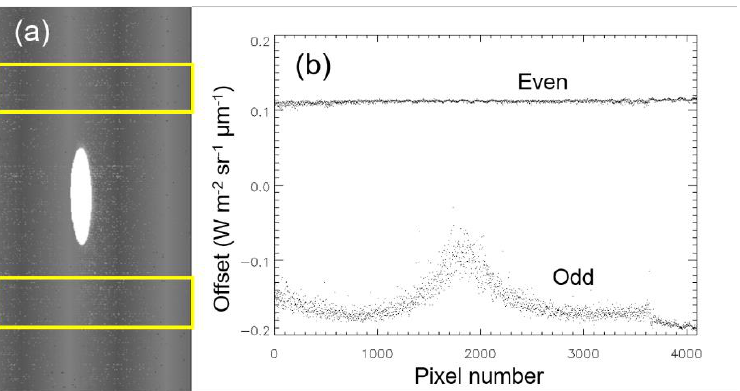
Figure 3. ( a ) An example of offset patterns observed in the VNIR images (Band 1, 2003). The brightness level was stretched to enhance the offset. ( b ) Measured offsets for each pixel obtained from averaging the apparent brightness in deepspace regions (indicated by the rectangular regions shown in ( a )). “Even” and “Odd” represent offset values for even pixels and odd pixels, respectively.